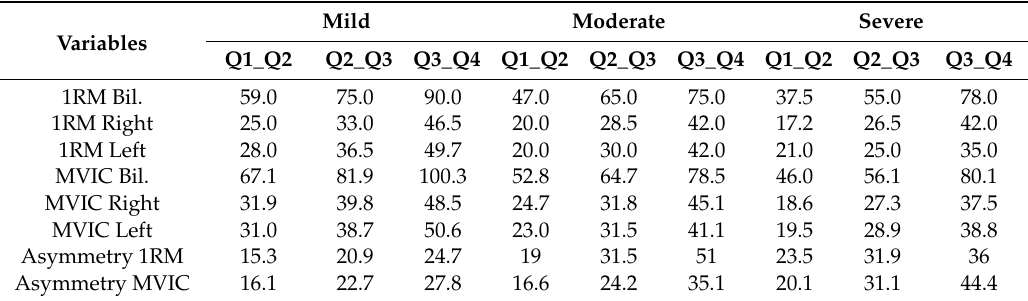
Table 7. Quartiles of force variables of sample by EDSS degree.